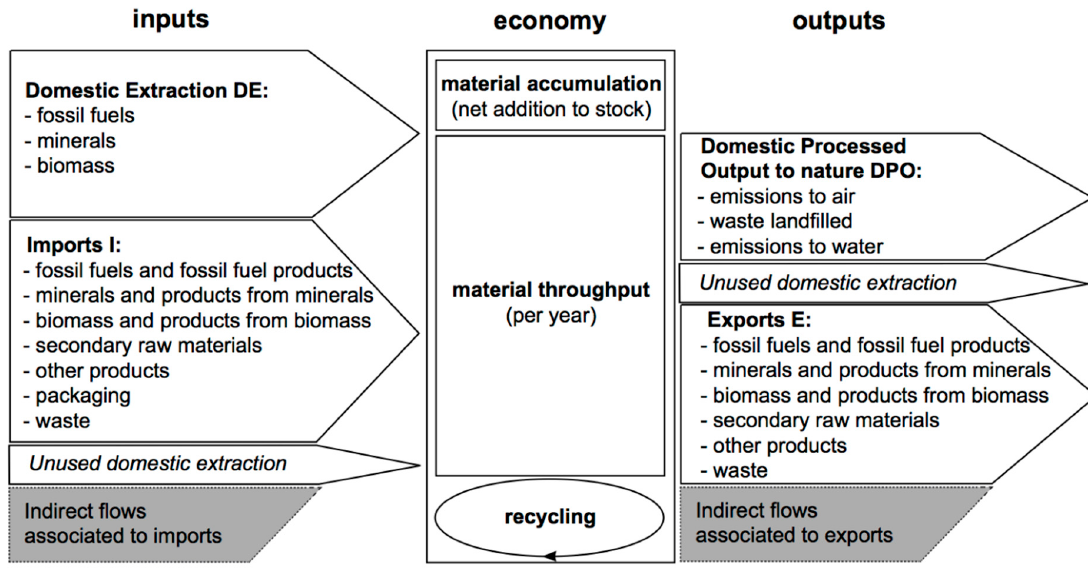
Figure 4. Eurostat’s Economy-Wide Material Flow Analysis (EW-MFA) with the main Inputs, Internal Stock/Cycling, and Outputs categories. Adapted from Eurostat, 2001 [59].